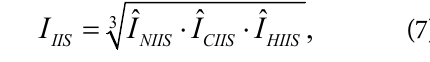
Table 8. Assessment levels of investment and